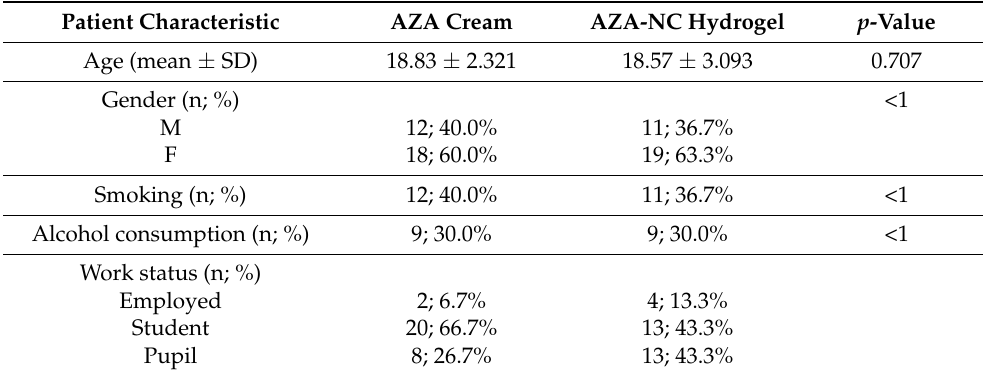
Table 2. Sociodemographic patient characteristics.